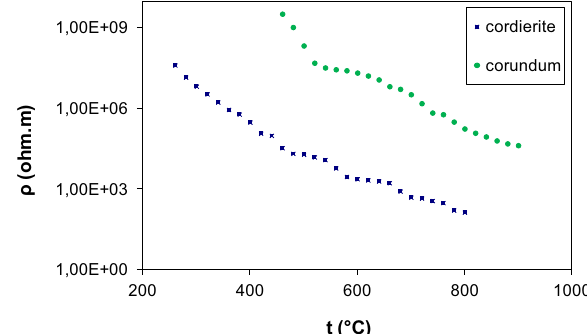
Fig. 3. Dependence of speci fi c electric resistance of tested ceramic materials on temperature.